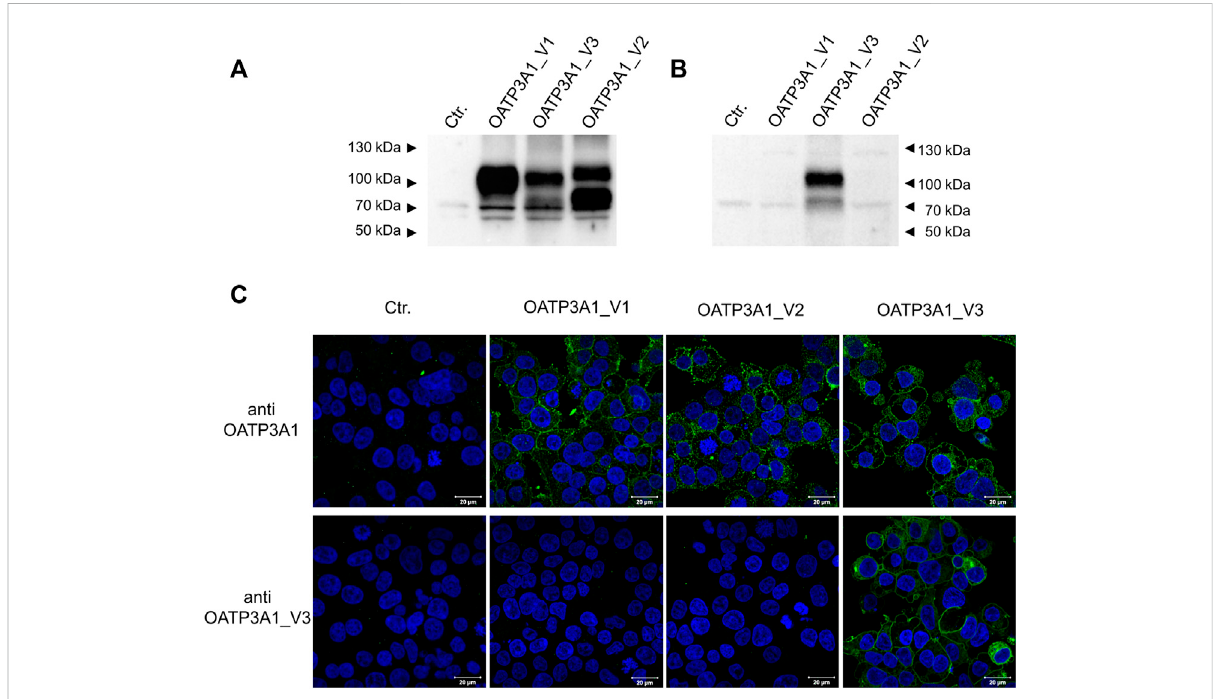
FIGURE 3 Speci fi city of the anti-OTP3A1_V3 antibody. (A,B) . Western blot analysis of HEK-293 cells overexpressing OATP3A1 variants. Western blot was performedon5 μ goftotalcelllysatesusingthepananti-OATP3A1antibody(Sigma) (A) ortheanti-OATP3A1_V3antibody(describedinMethods) (B) . Control (ctr.) represents mock-transfected HEK-293 cells. A representative blot of three independent experiments is shown. (C) Immuno fl uorescence staining of HEK-293 cells overexpressing OATP3A1 variants. Cells were fi xed and labeled with the pan anti-OATP3A1 antibody (upper panel) or the anti-OATP3A1_V3 antibody (lower panel) (green). Nuclei were stained with DAPI (blue). Representative images are shown. Scale bar: 20 μ